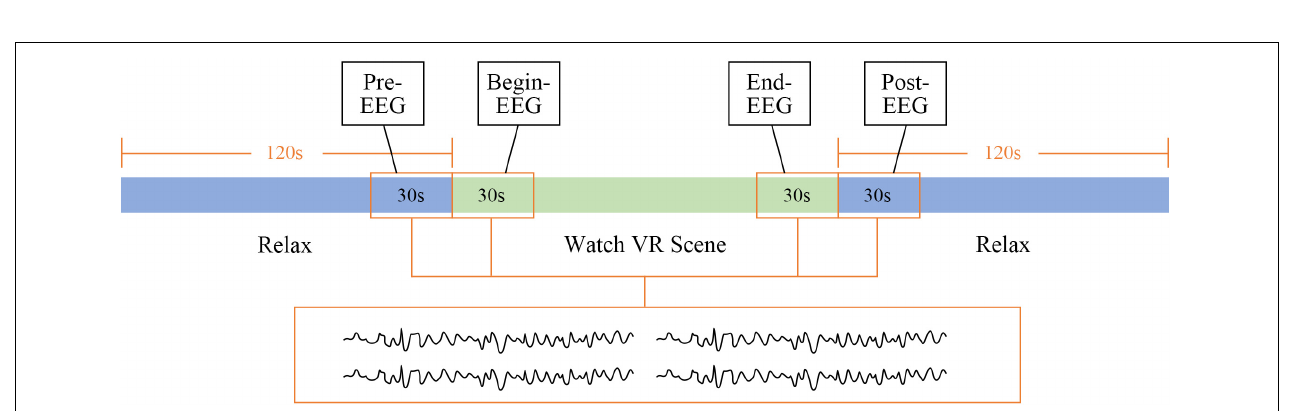
FIGURE 5 | Selected electroencephalogram (EEG) data.